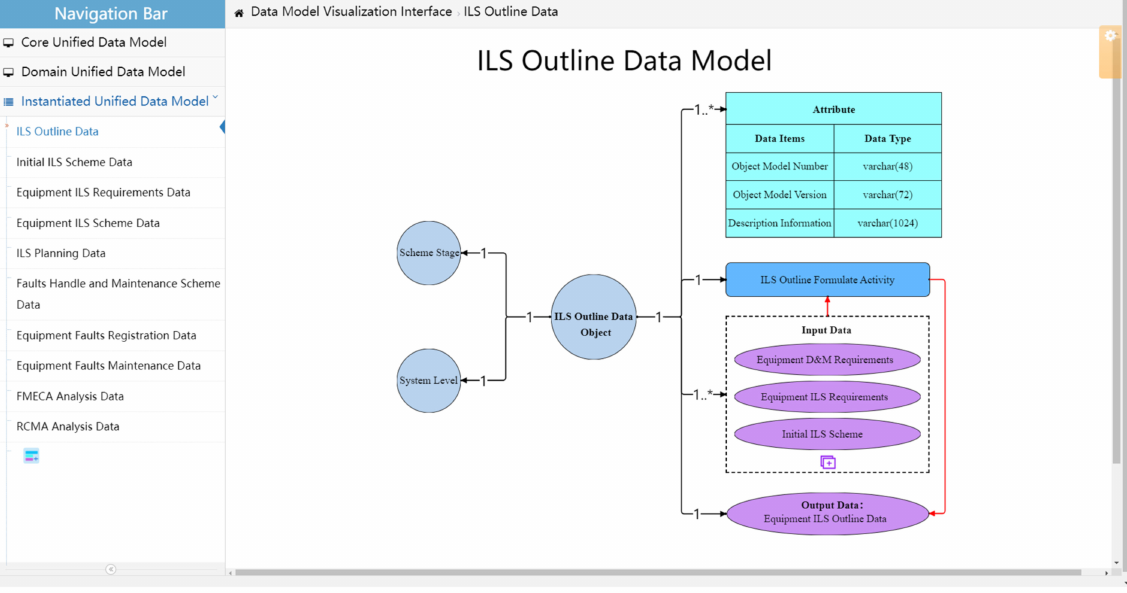
Figure 15. Instantiated unified data model